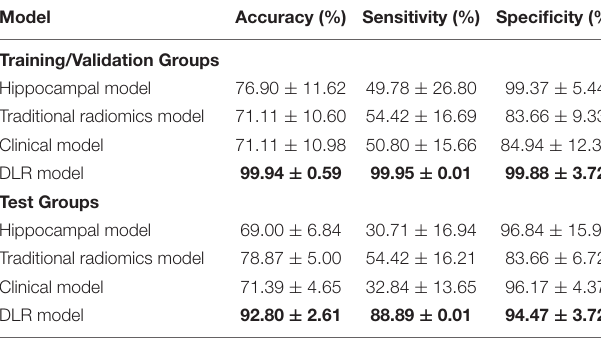
Bold values represent the classification performance of our proposed model.